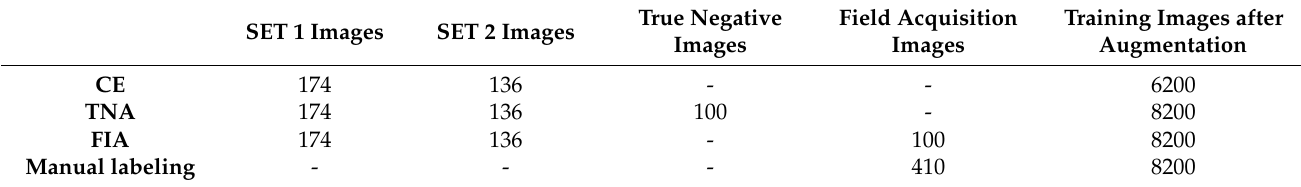
Table 1. Data sets used for